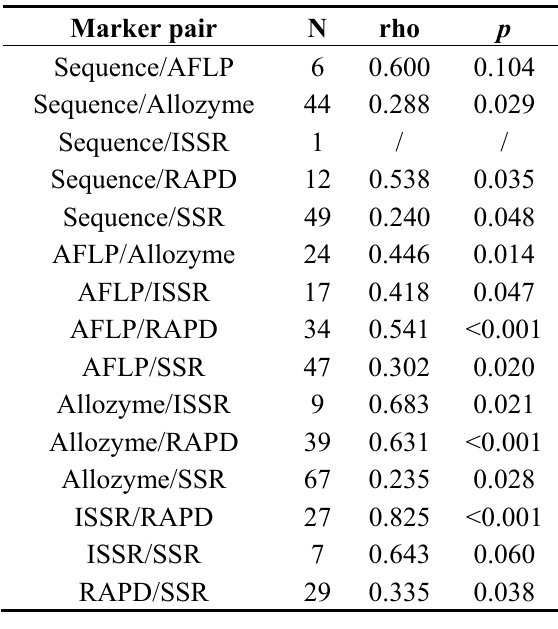
Table 2. Summary of the numbers of taxa, Spearman’s coefficients and one-tailed significance tests for correlation analyses among nucleotide sequences and the five molecular